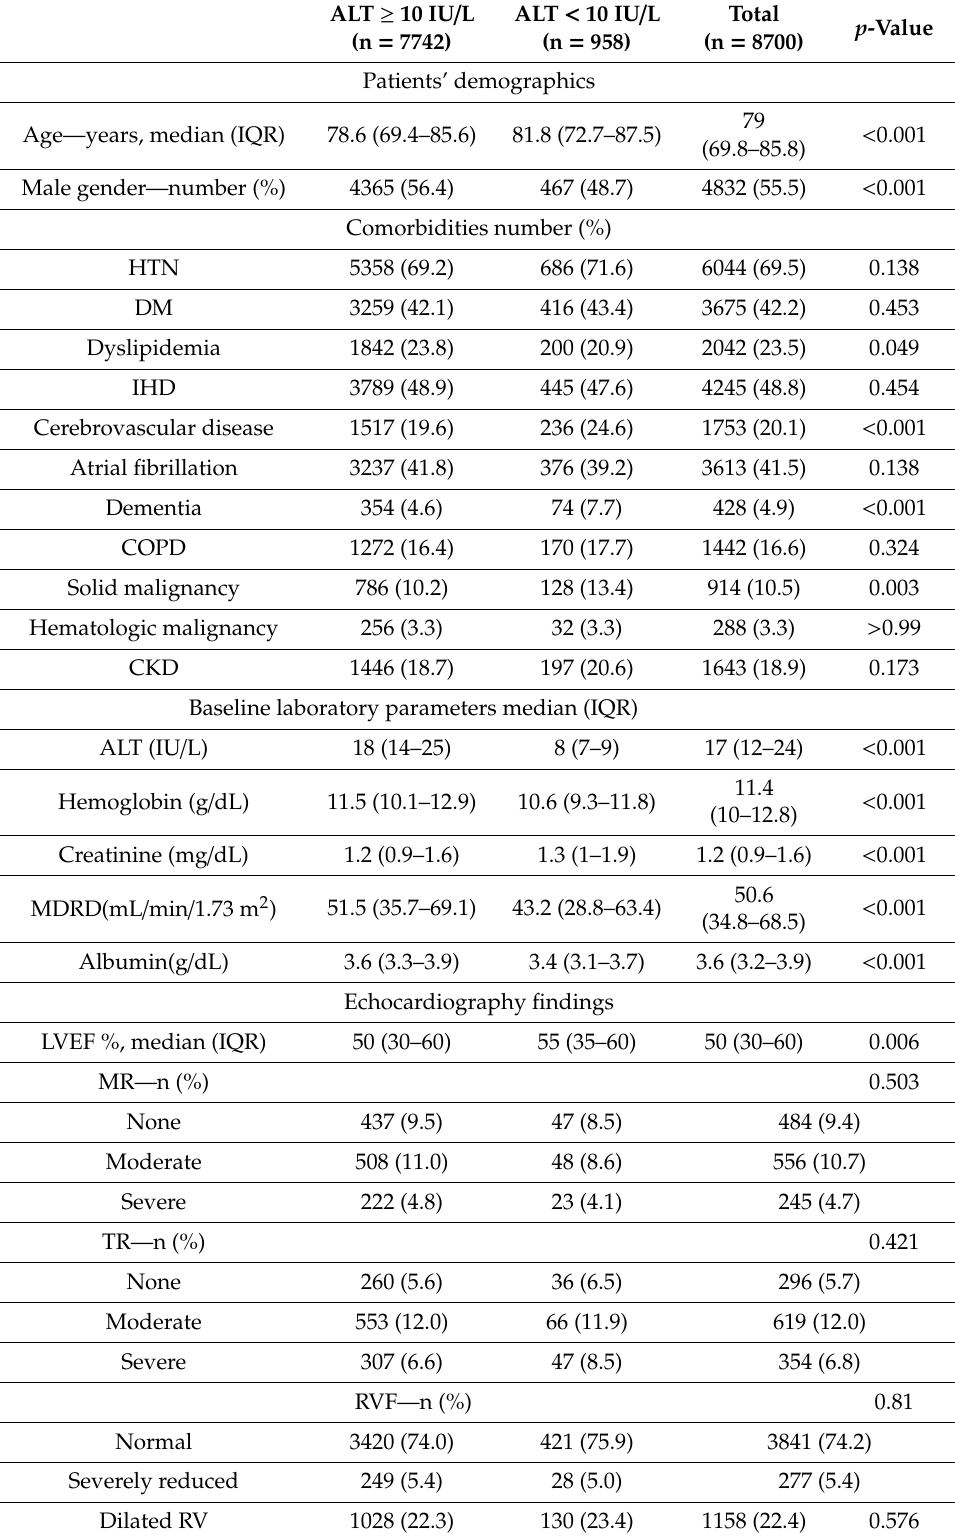
Table 1. Patients’ characteristics according to their baseline alanine transaminase (ALT) blood activity